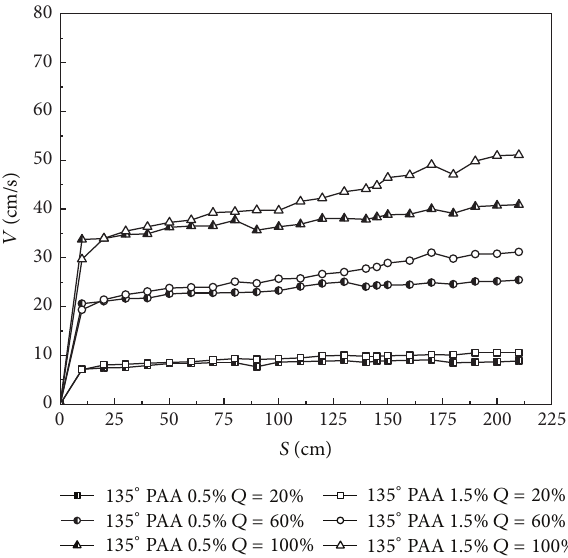
Figure 8: The CMC velocity-position diagram of various flow in 90 ∘ curved tube.